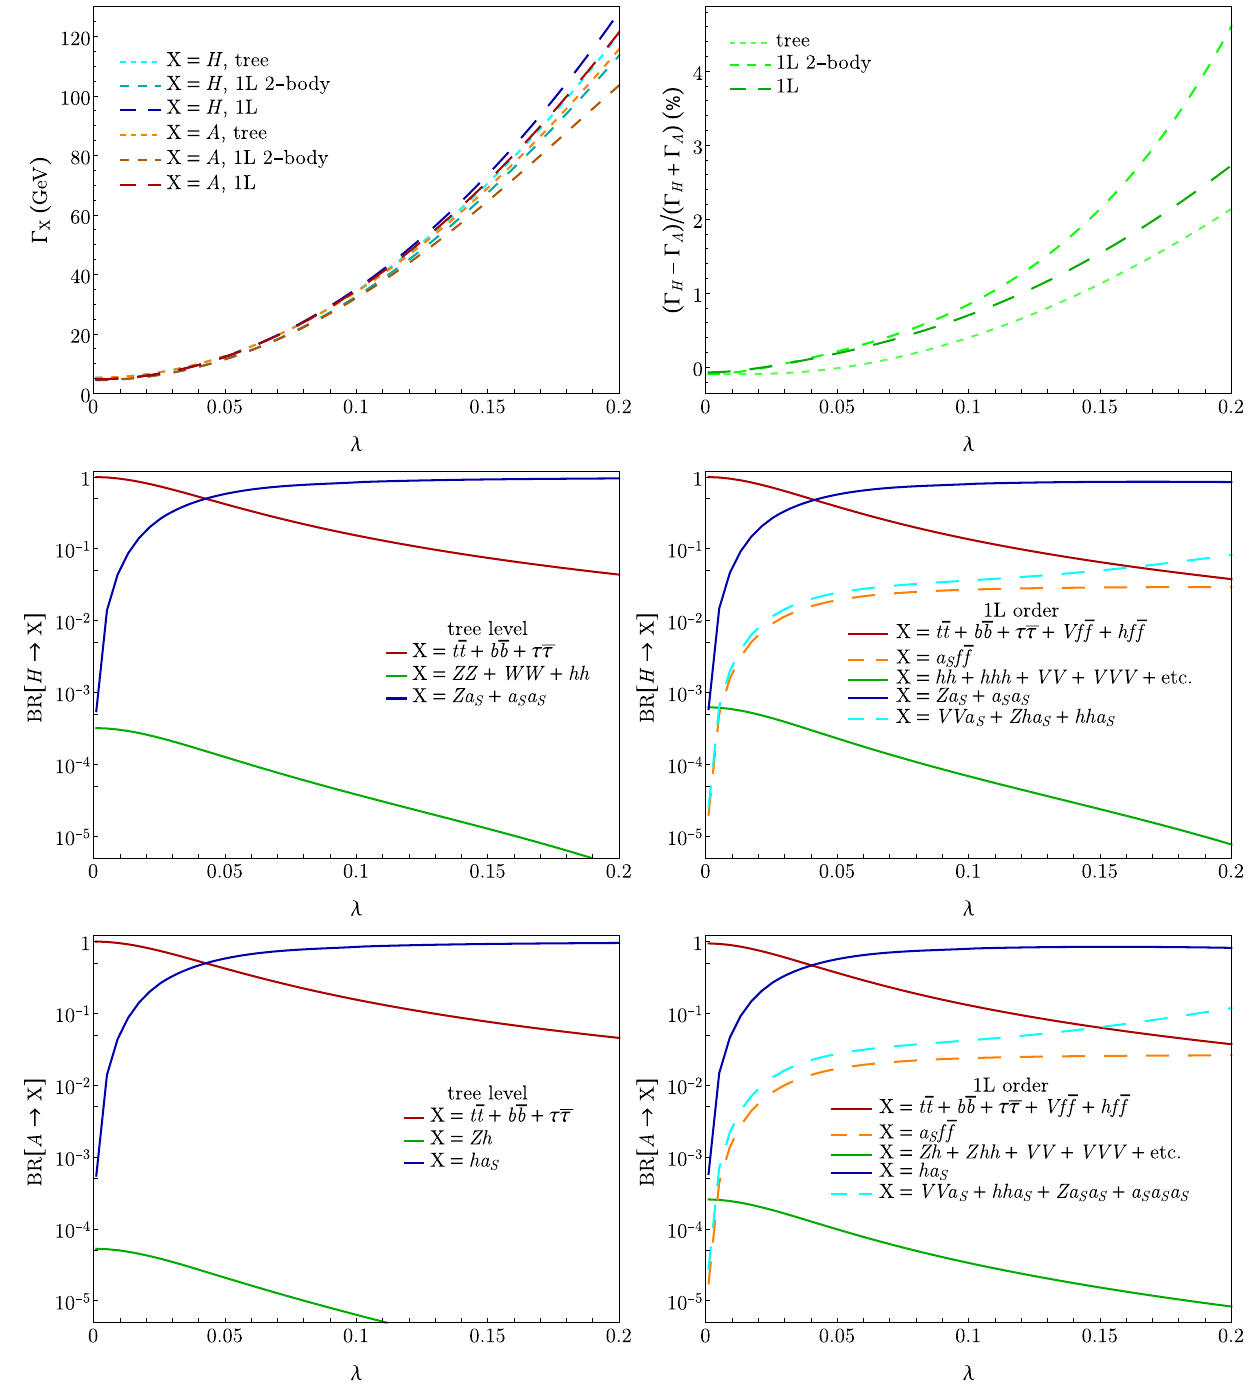
CP -odd) at tree-level (left) and 1L order (right) in the scenario of Fig. 4. Decaymodesinvolving a S aredepictedinsolidblue(two-body),dashed orange (fermionic three-body) and dashed cyan (bosonic